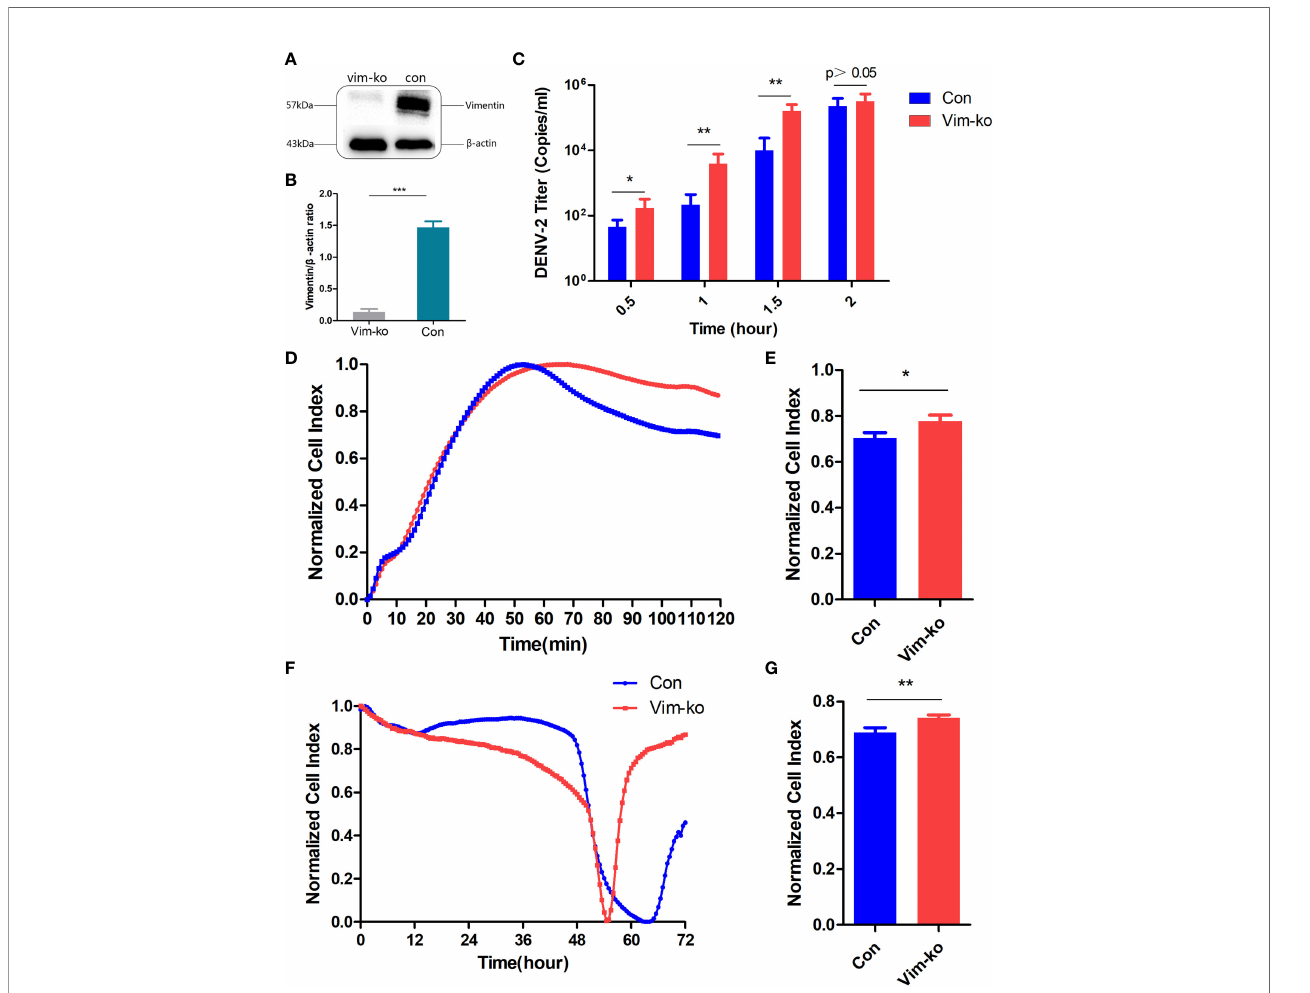
FIGURE 3 | Vimentin might inhibit dengue virus (DENV)-2 invasion of human brain microvascular endothelial cells (HBMECs). (A) Vimentin expression in HBMECs (Con and Vim-KO). (B) Gray scale analysis of Figure (A, C) DENV-2 titers of intracellular virus in HBMECs (Con and Vim-KO). (D, E) Dynamic curves and normalized cell index of DENV-2 infected HBMECs (Con and Vim-KO) within 2h. (F, G) Dynamic curves and normalized cell index of DENV-2 cultured with HBMECs (Con and Vim-KO) within 72h. (B, C, E, G) *P < 0.05; **P < 0.01; ***P <